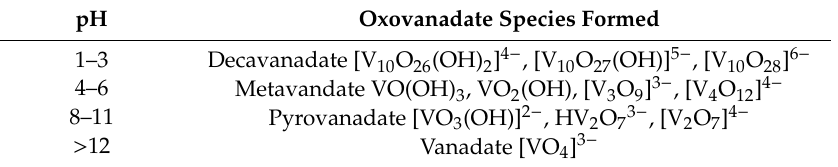
Table 3. The polymerization degree of oxovanadates versus pH. Information taken from Ref.